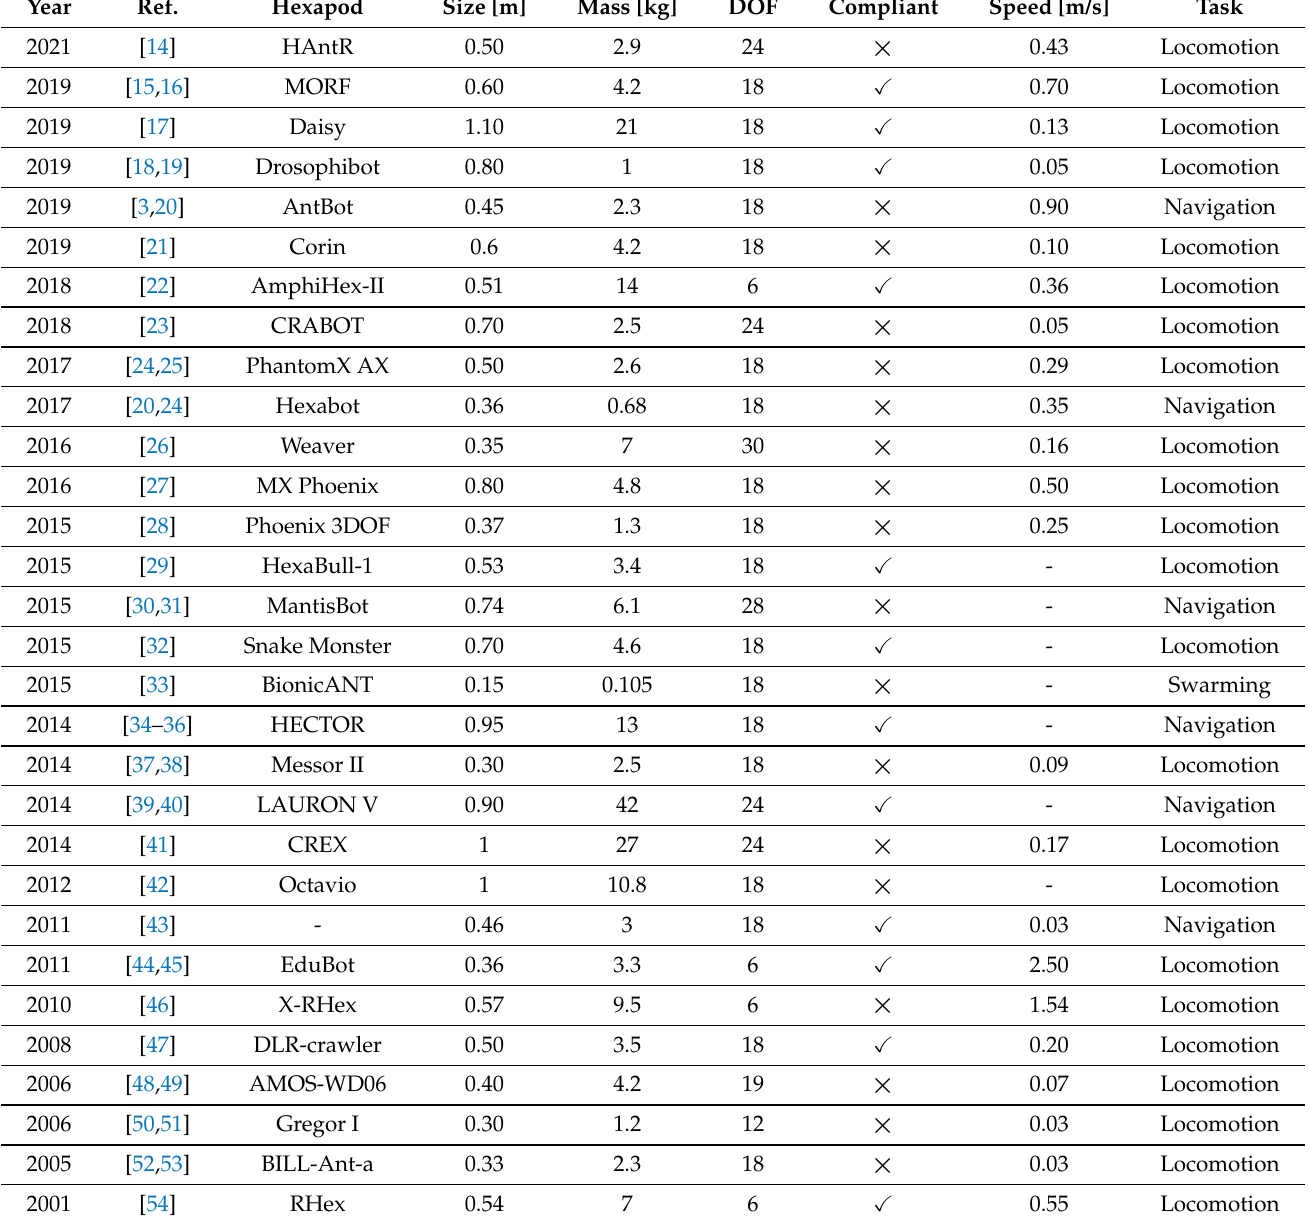
Table 1. Overview of the state-of-the-art hexapod robots developed over the last 20 years in the range 1 ∼ 27 kg. The size, given in meters, corresponds to the largest dimension between width and height. DOF stands for Degrees Of Freedom for the entire robot (note that this can include extra actuation for head control and body control). The speed represents the maximum speed measured, in meters per second. The symbol “-” represents missing